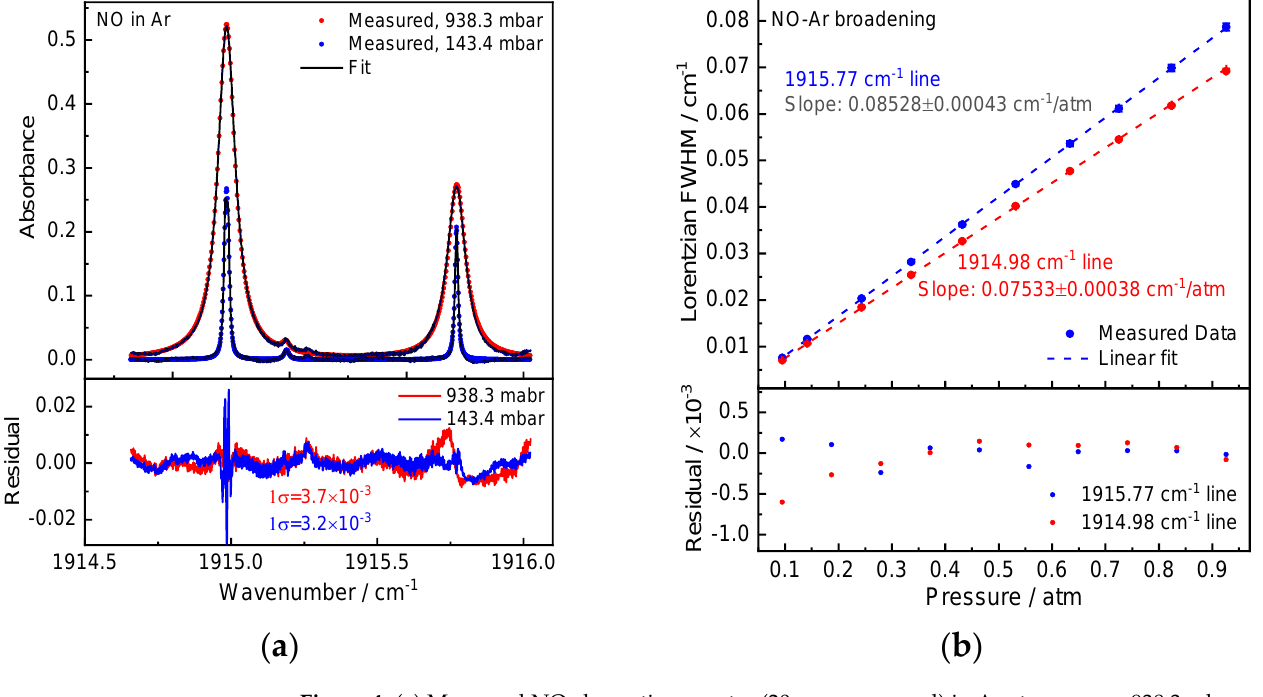
Figure 4. ( a ) Measured NO absorption spectra (20-scan averaged) in Ar at pressures 938.3 mbar and 143.4 mbar. ( b ) Experimentally obtained Ar-induced pressure broadening of the NO absorption lines fitted with a linear model. The residual between the data and the fit is displayed below.